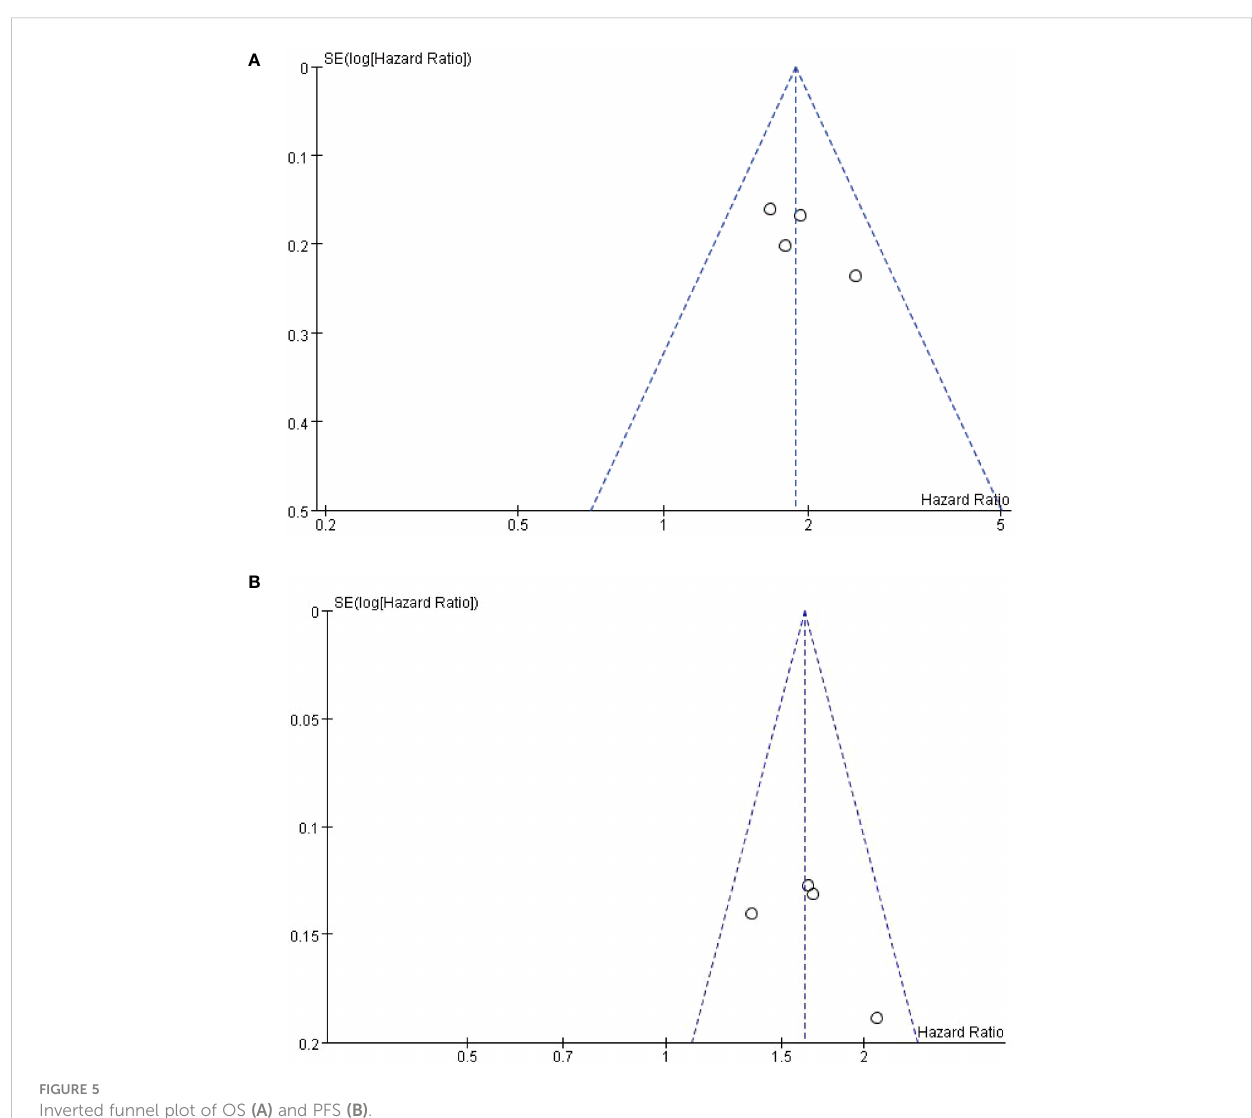
FIGURE 5 Inverted funnel plot of OS (A) and PFS (B)